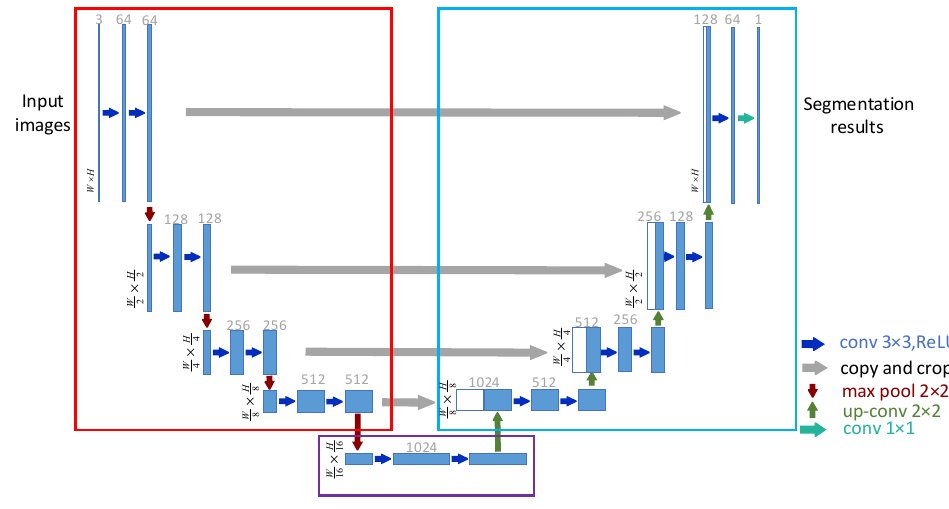
Figure 2. U-Net network Figure 2. U ‐ Net network structure.